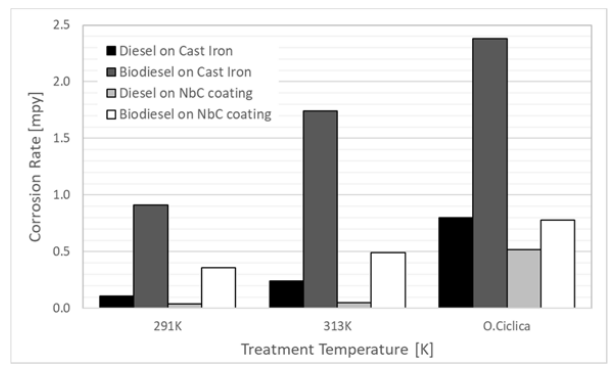
Figure 5. Corrosion rates of the gray cast iron and NbC coating in diesel and biodiesel.